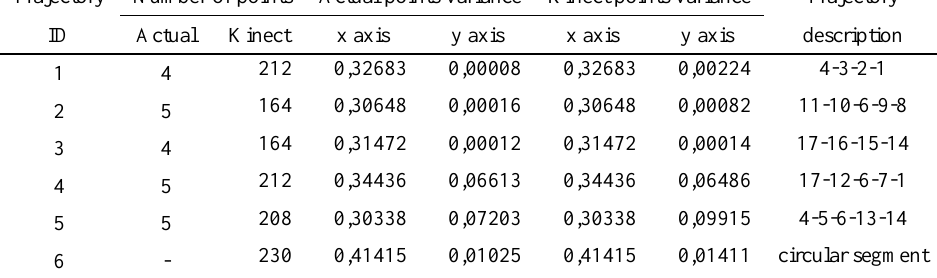
Table 1. Designed (actual) trajectories related information. Additional information regarding the distribution of the Kinect’s projected trajectory points is provided.